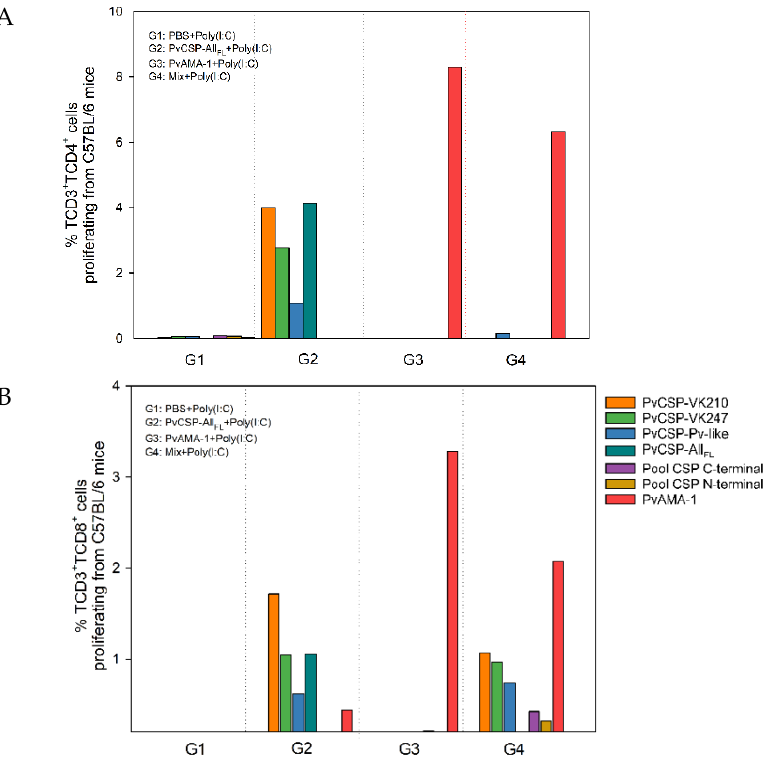
Figure 5. Lymphocyte proliferation from C57BL/6 mice immunized with formulation containing PvCSP-All FL , PvAMA-1, and poly(I:C) adjuvant. Pooled splenocytes were collected from immunized C57BL/6 mice. The cells stained with carboxyfluorescein diacetate succinimidyl ester (CFSE) were plated and stimulated (for five days) with homologous proteins or one of the PvCSP variants (10 µ g) or pooled synthetic peptides (26 µ g), which covered the entire length of the C- or N-terminal PvCSP or mitogen-concanavalin A (2.5 µ g). The events were acquired in the FACSCanto II and analyzed using the software FlowJo ® . The results are expressed as percentage (%) of TCD4 + ( A ) or TCD8 + ( B ) proliferative cells. These data are representative of two independent assays from a pool of three immunized mice.